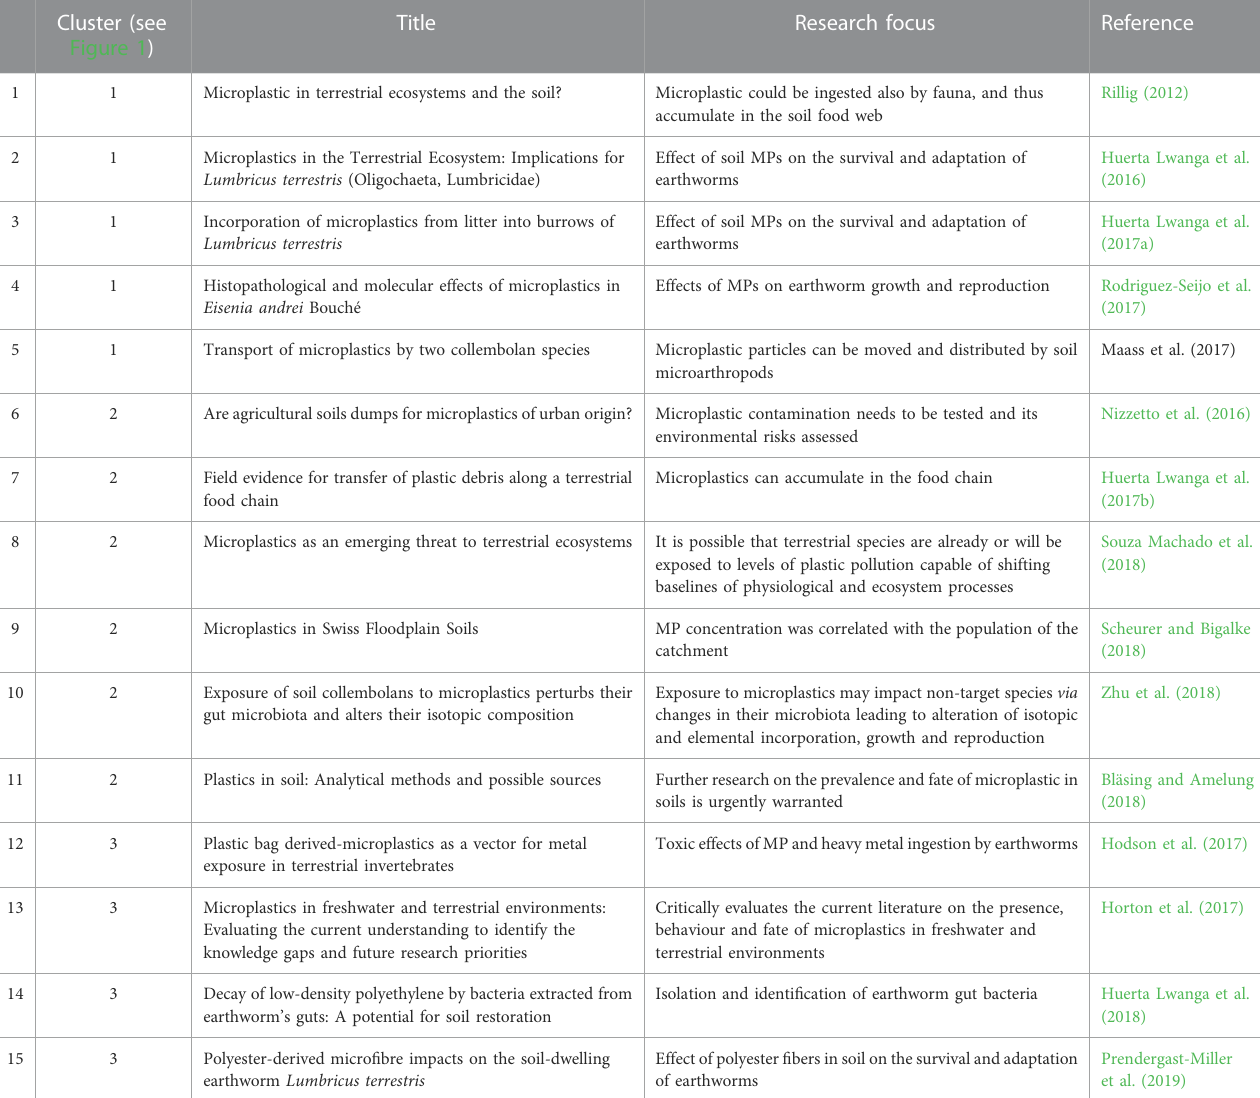
TABLE 2 Co-cited literature on the interactions between microplastics (MPs) and earthworms (published up to December 2021). Cluster (see Figure